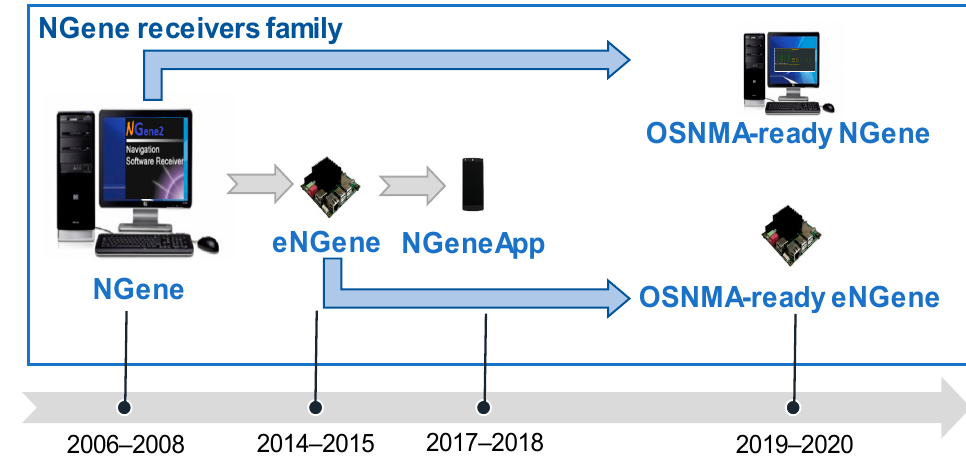
Figure 2. NGene: the set of receivers belonging to the family and their derivation.